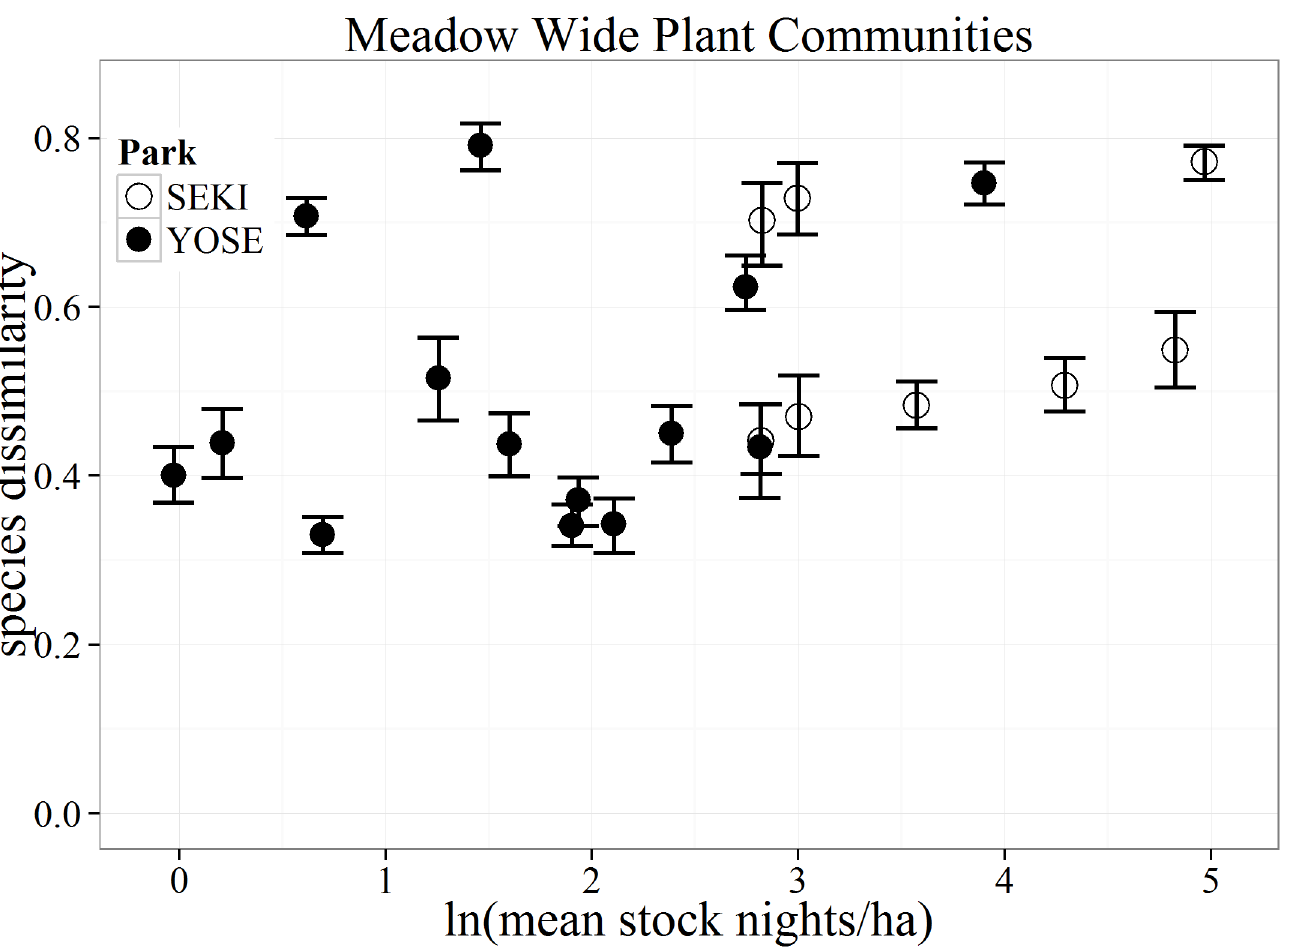
Fig 7. Bootstrapped mean (with 95% confidence intervals) differences in species composition (as Bray-Curtis dissimilarity distances) for all vegetation communities between matched stock and non-stock meadows (N = 22) in Yosemite (YOSE) and Sequoia (SEKI) National Parks.